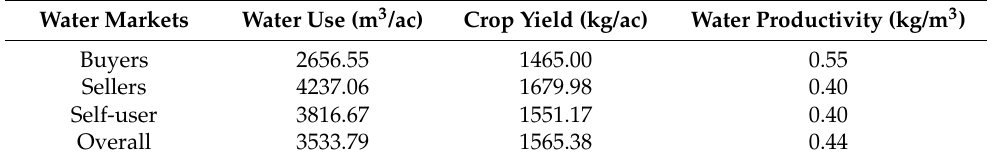
Table 7. Water productivity across different water